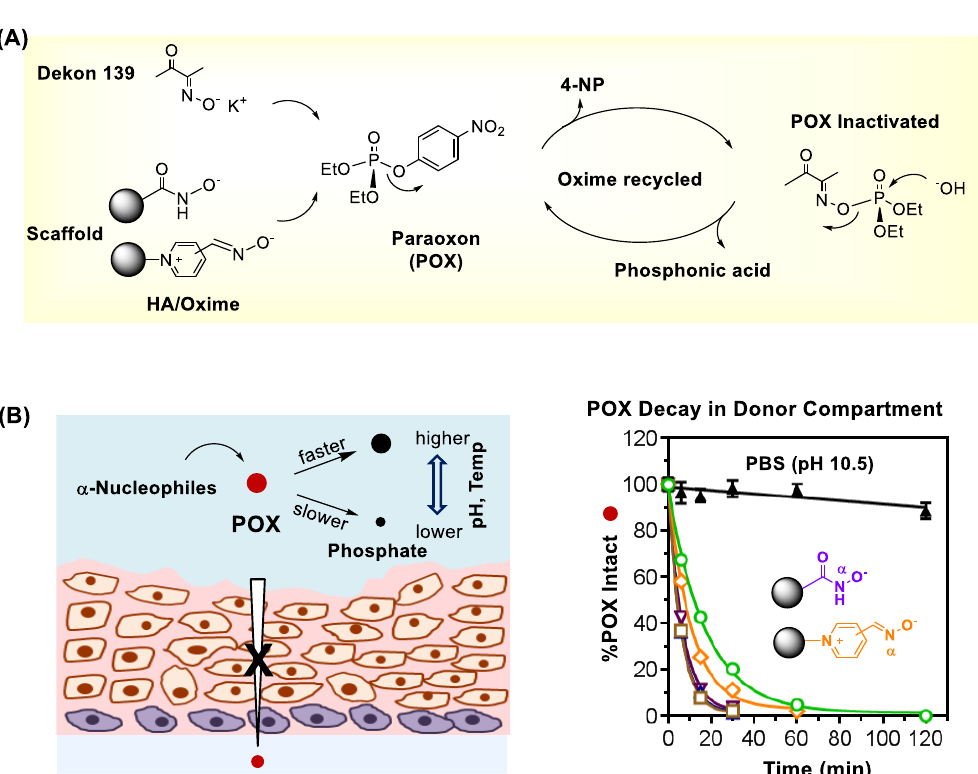
Figure 6. ( A ) The mechanism of hydrolytic organophosphate (OP) inactivation by oxime or hydroxamate (HA)-based scavengers as illustrated with paraoxon ethyl (POX). ( B ) Topical decontamination of porcine skin exposed to POX ex vivo by treatment with chemical scavengers Dekon 139 and oxime/HA ( α -nucleophile) scaffolds (left) and decay curves of POX in the donor chamber (right). Reproduced with permission from [16], Copyright 2019, The Royal Society of Chemistry.